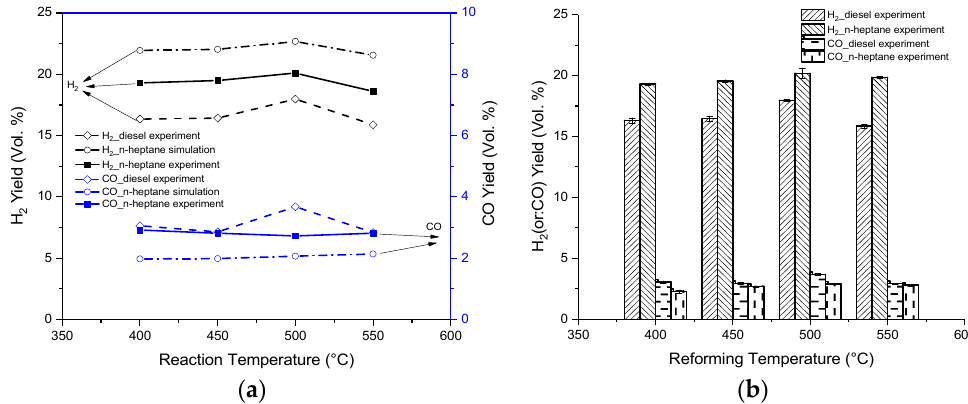
Figure 7. H 2 and CO yield comparison results at different reaction temperatures: ( a ) comparison of simulations and experiments; ( b ) error bars of the experimental results.